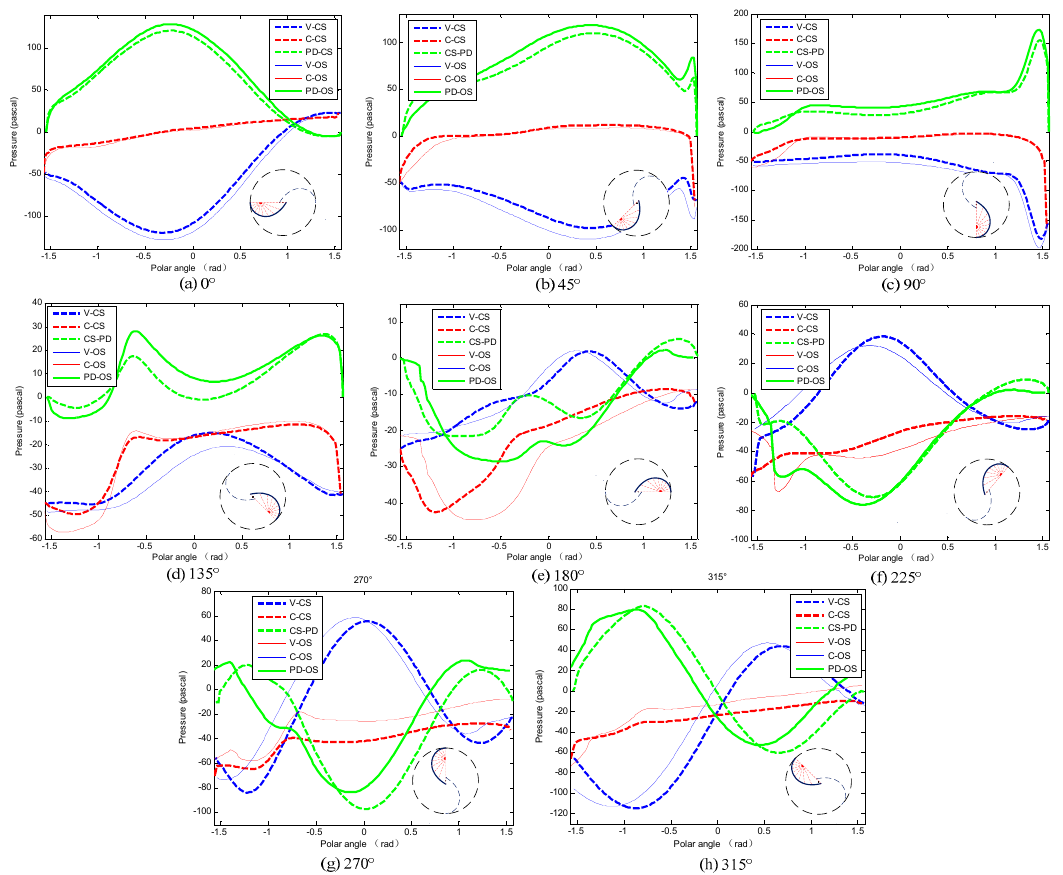
Figure 19. Pressure distributions of a single blade at different rotors angular positions.